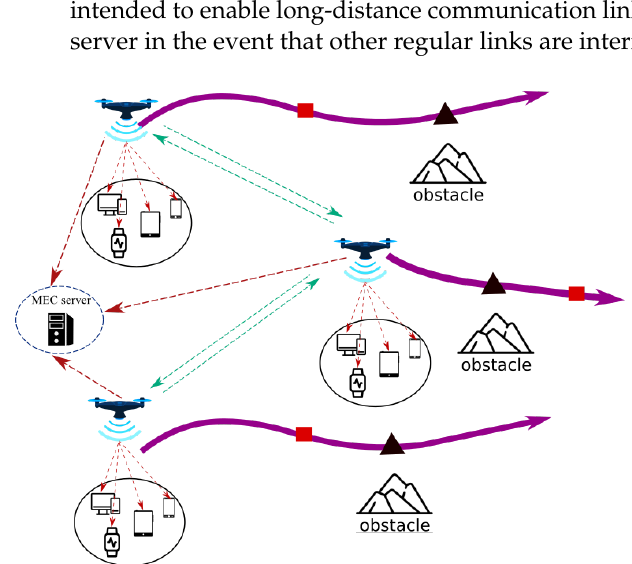
Figure 3. Relayed MEC architecture.